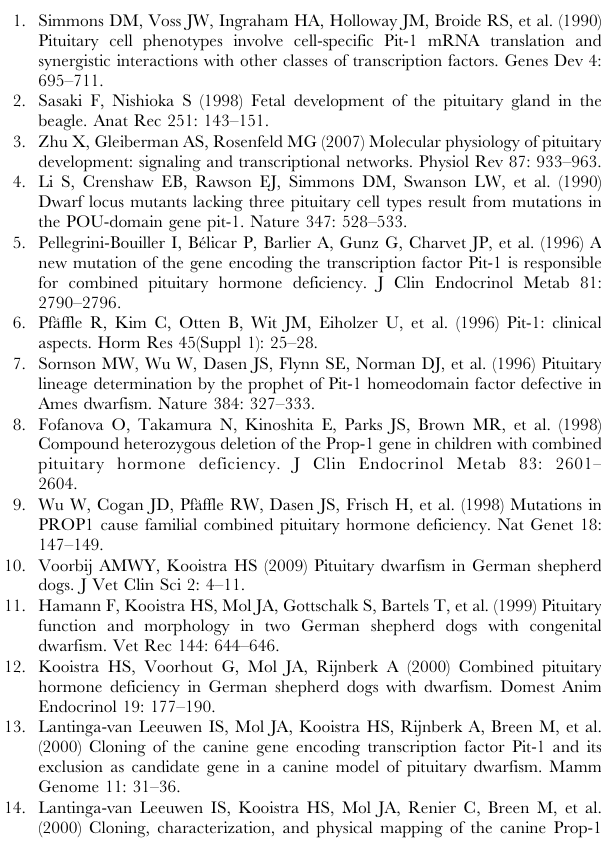
Table S1 Size and DNA sequence of intron 5 of LHX3 in mammals. Table S2 Birth year, sex and origin of German shep- herd dogs included in the study of pituitary dwarfism. Table S3 Genome wide set of microsatellite markers. Table S4 DNA sequences of oligonucleotides used in the study of pituitary